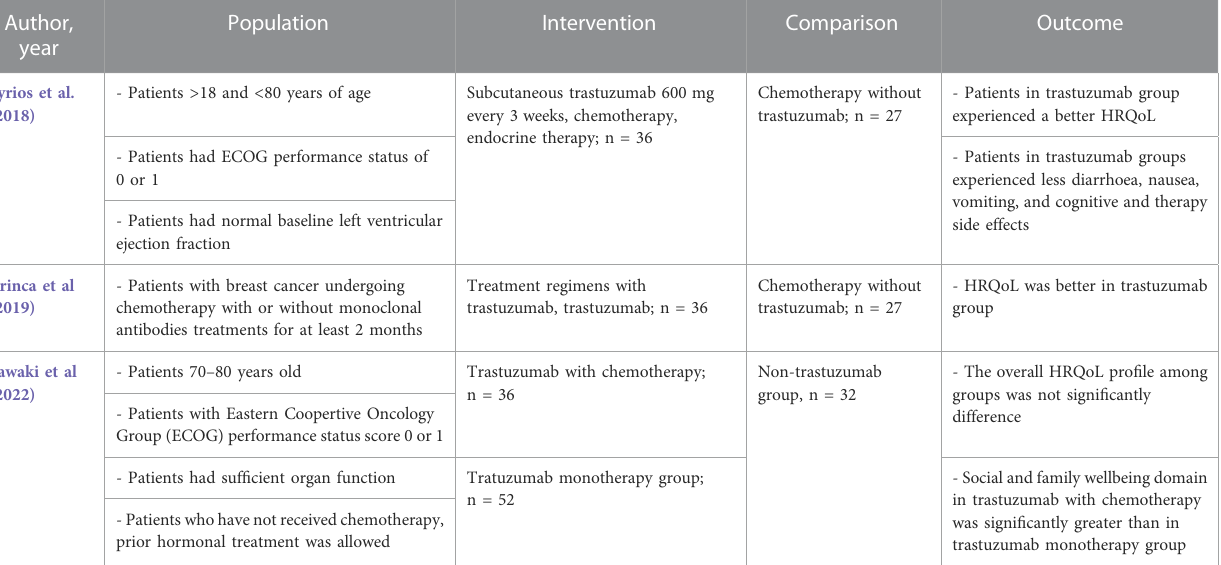
TABLE 3 Pro fi le of HRQoL for cross-sectional studies.